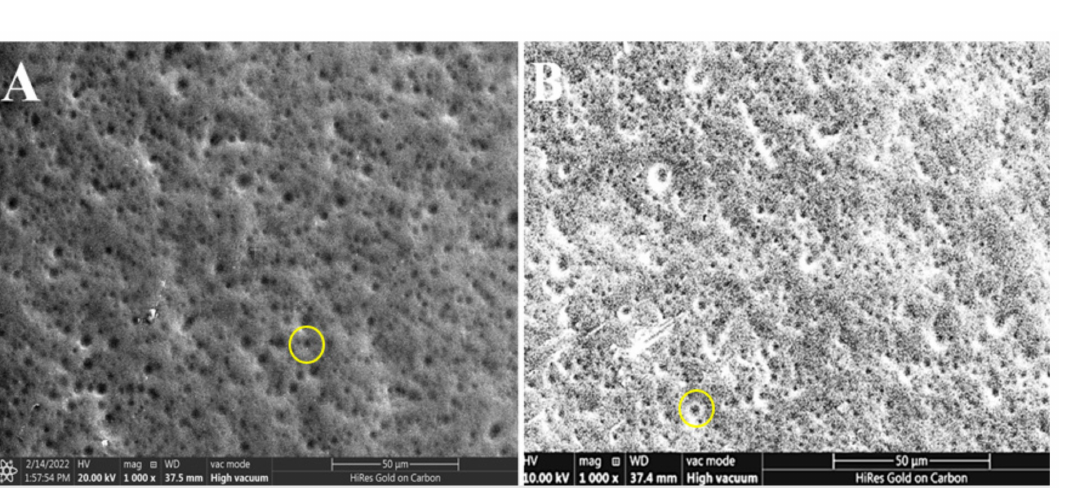
Figure 5. ( A ) The scanning electron microscope (SEM) image of the blank chitosan–alginate nanopar- ticles and ( B ) the SEM image of the nerolidol-loaded chitosan–alginate nanoparticles. The yellow circle on both figures shows the sphere-like nanoparticles